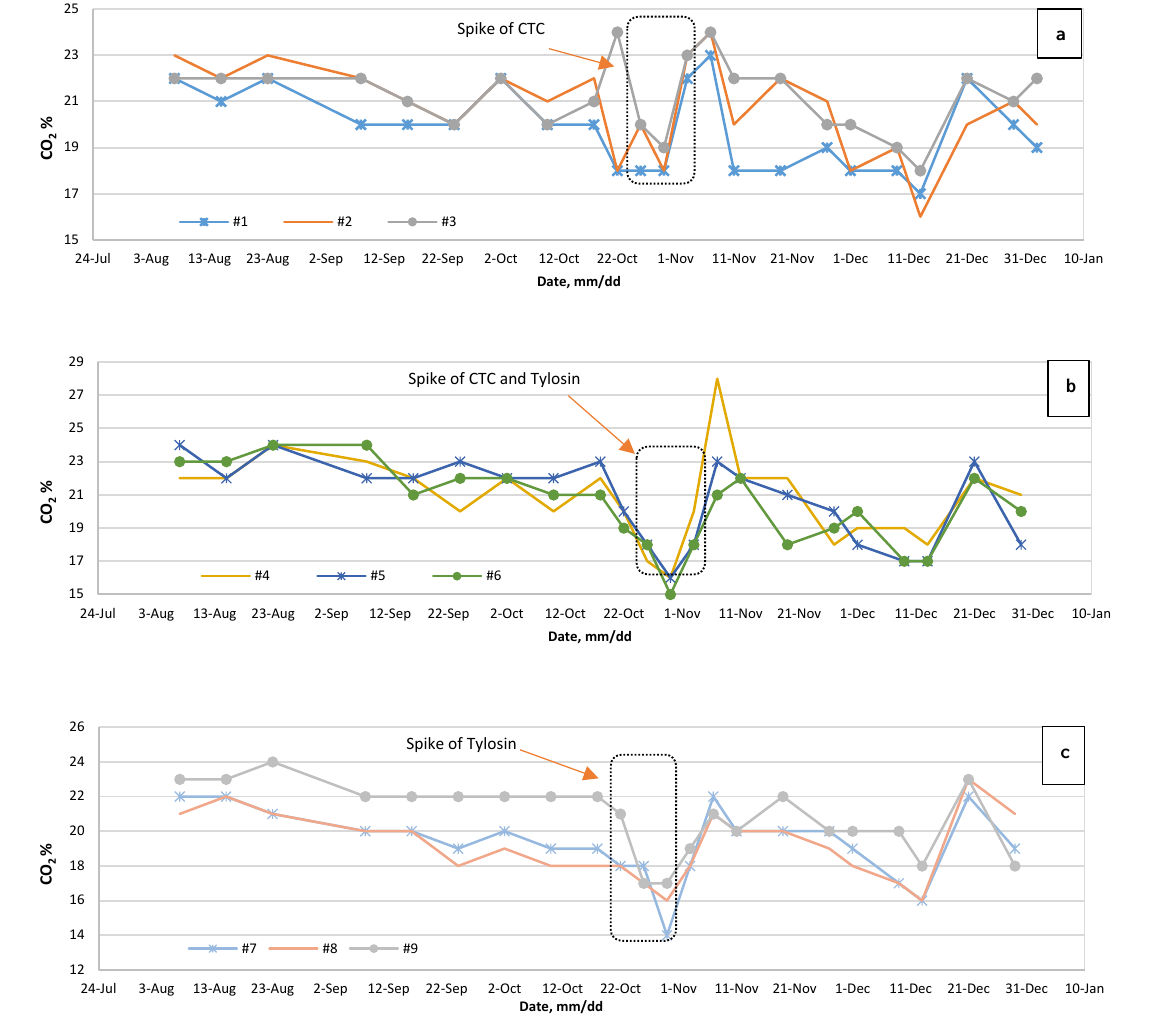
Figure 4. The concentrations of CO 2 ( a ) before and after CTC spike, ( b ) before and after CTC plus tylosin spike, and ( c ) before and after tylosin spike and the dotted box shows the administration period of the VAs.